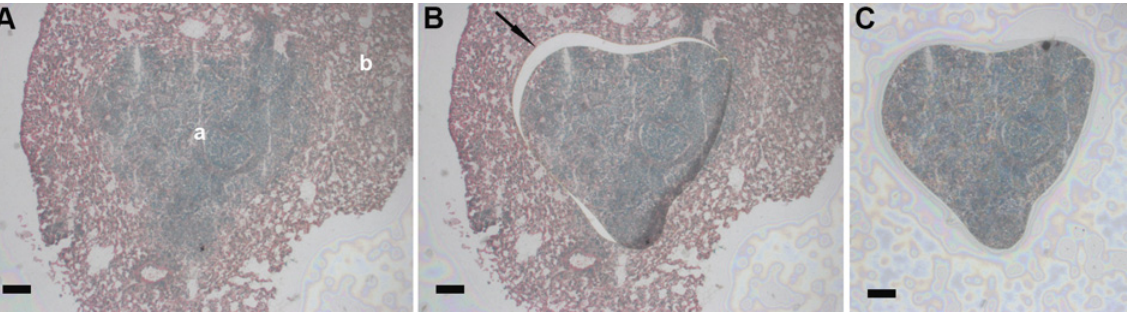
Fig 2. Documentation of lung metastasis removal from a mouse lung parenchyma by laser cutting. (A) Dissecting screen view of metastasis (a) in a mouse lung parenchyma (b); (B) Dissecting screen view of lung metastasis with the laser cut path (arrow); (C) View of LCM target cutout on the collection cap. Scale bars correspond to 100 μ